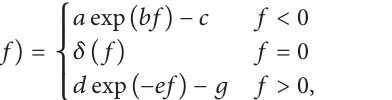
lower frequencies. All the PSDs are normalized with respect to the 0 Hz component prior to characterization [25,